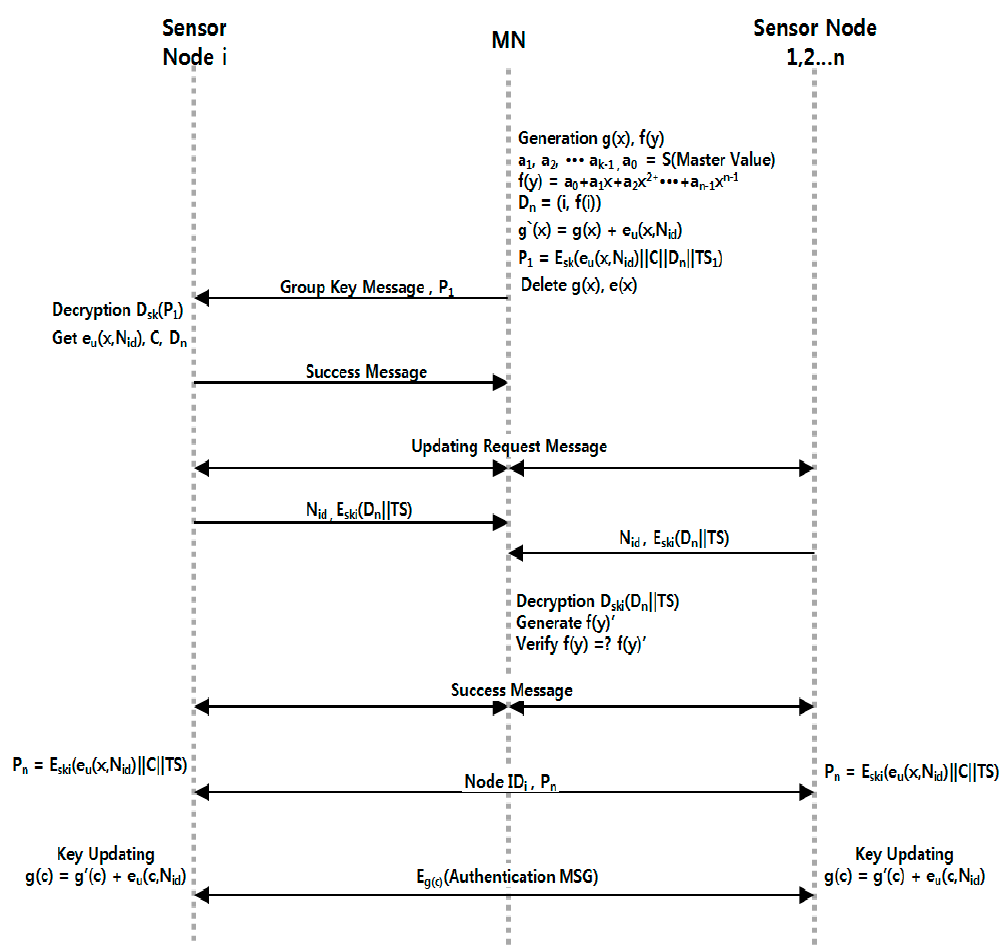
Figure 6. Group key updating process.